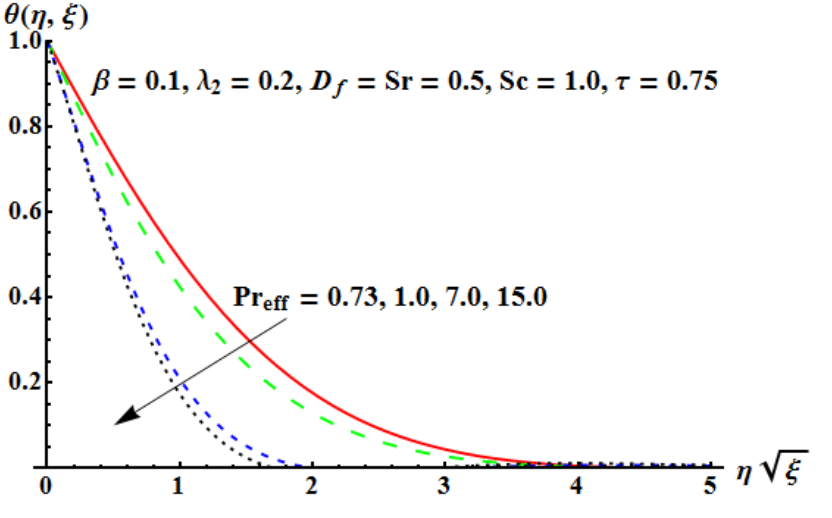
Figure 11. Influence of Pr ef f on θ ( η , ξ ) .